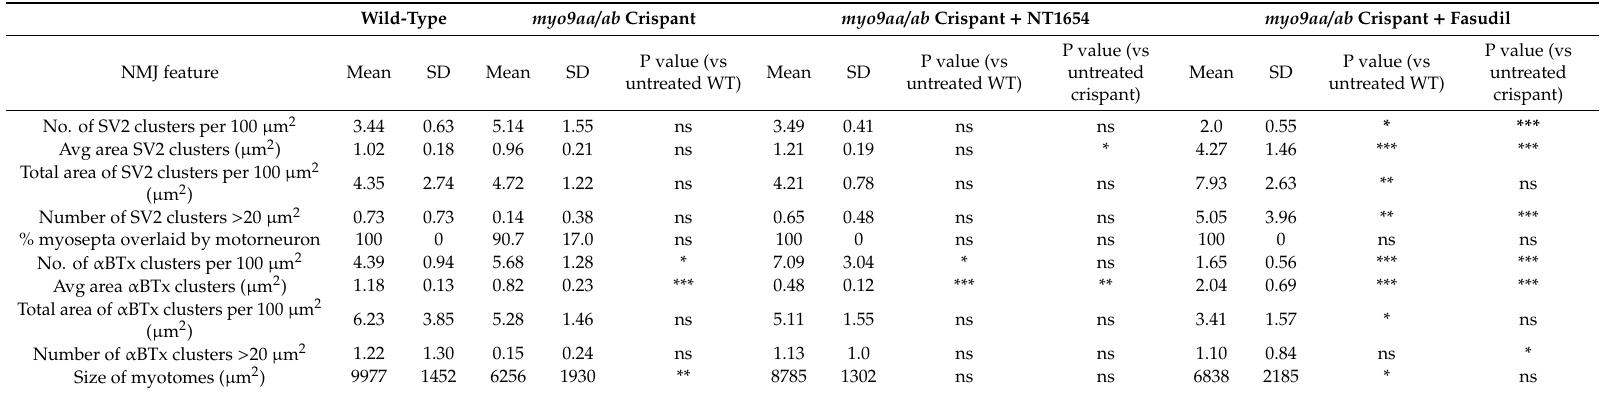
Table 3. NMJ morphology of myo9aa / ab crispant zebrafish at 120 hpf. A number of features of developing NMJs were characterised in wild-type ( n = 10 fish), myo9aa / ab crispant ( n = 7 fish), NT1654-treated (0.15 ng, n = 8 fish) crispant, and fasudil-treated (10 µ m, n = 10 fish) crispant fish, encompassing both pre- and postsynaptic regions. The mean value, standard deviation (SD), and p-value are shown for each measurement, with treated fish compared to untreated crispants and wild-type zebrafish. Number of SV2 / α BTx clusters > 20 µ m 2 , % myosepta overlaid by motor neuron, total SV2 / α BTx area per 100 µ m 2 , number SV2 clusters